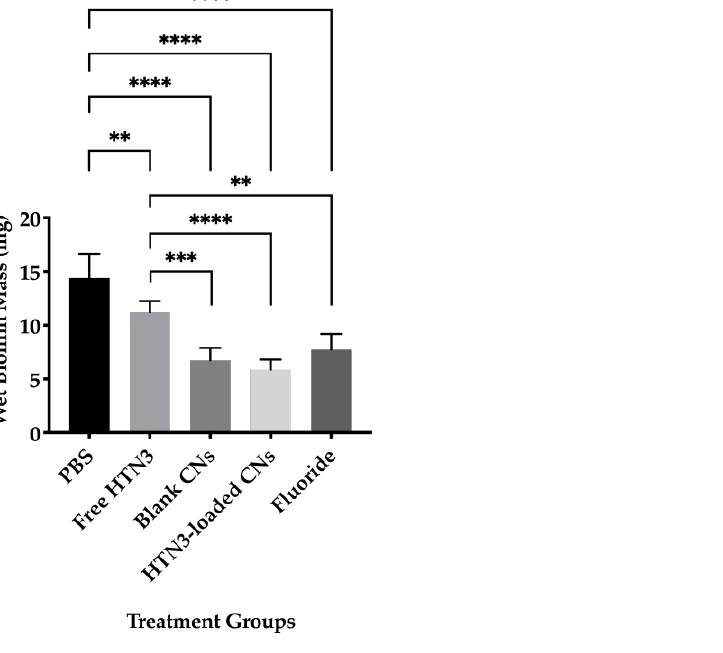
Figure 6. Wet biofilm masses for four treatment groups were compared against the control group PBS. All treatment groups led to significantly lower biofilm mass than PBS. Fluoride, blank, and histatin encapsulated CNs performed significantly better than free HTN3 in minimizing biofilm formation, but no significant difference in biofilm mass was observed between these treatment groups (** p ≤ 0.01, *** p ≤ 0.001, **** p ≤ 0.0001). Bacterial cell viability was also evaluated and presented in Figure 7. The PBS control led to 5.0 × 10 9 ± 0.4 × 10 8 CFU/mL of viable bacteria, while free HTN3 had 4.6 × 10 9 ± 0.3 × 10 9 CFU/mL, fluoride had 3.8 × 10 9 ± 0.5 × 10 9 CFU/mL, unloaded CNs had 2.7 × 10 9 ± 0.4 × 10 9 CFU/mL, and HTN3-loaded CNs had 2.3 × 10 9 ± 0.3 × 10 9 CFU/mL.